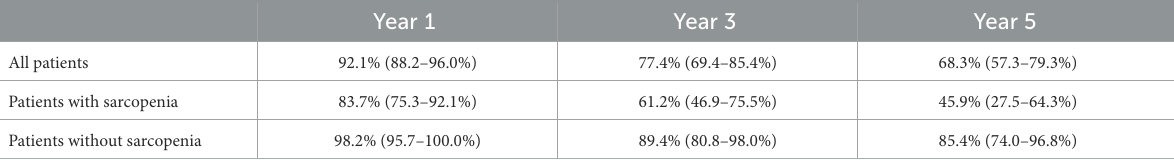
TABLE 2 Cumulative probabilities (with 95% CI) of survival.